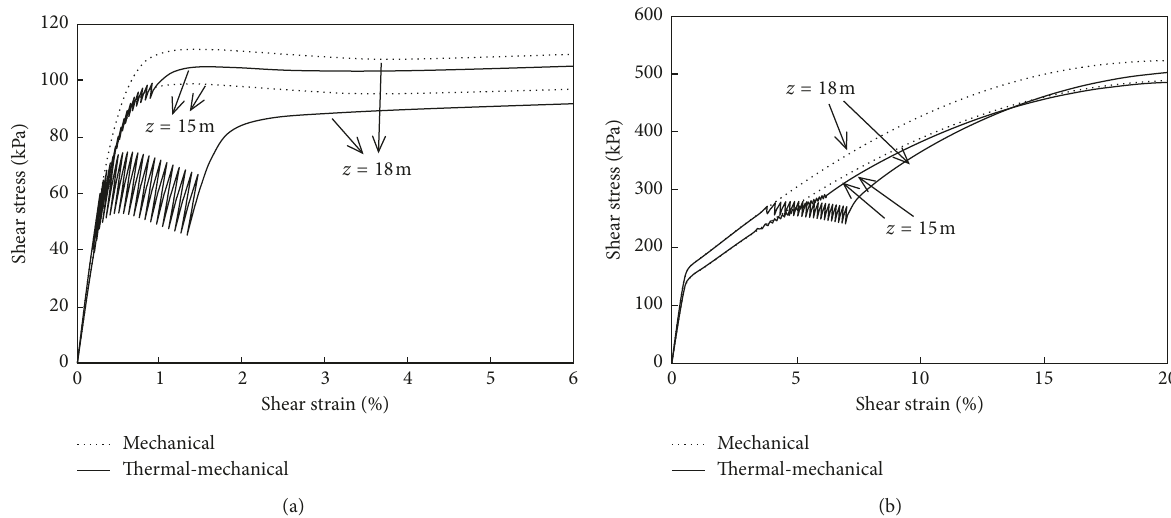
Figure 14: Development of shear stress at pile-soil interface for the free head pile. (a) Pile in loose sand. (b) Pile in dense sand.